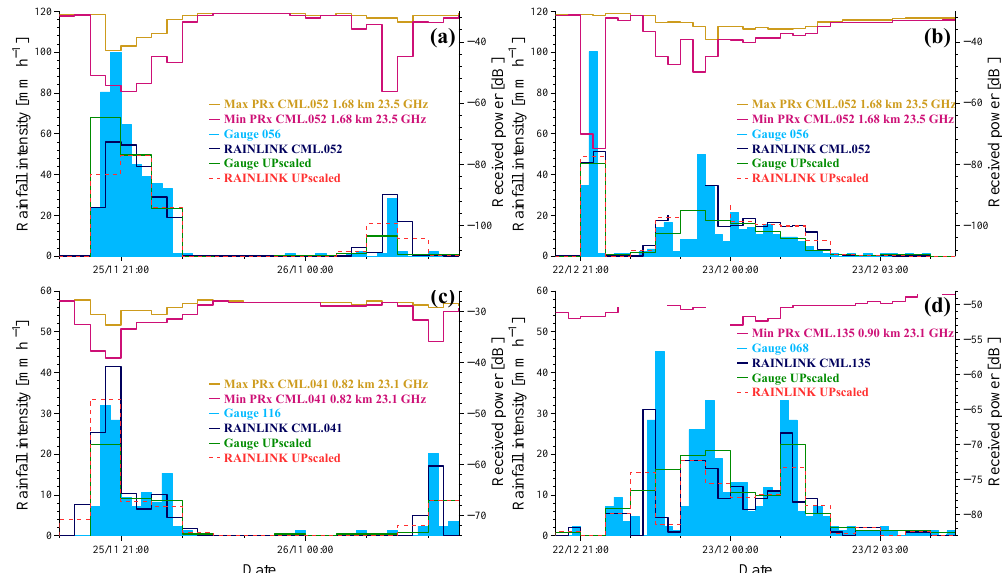
Figure 5. Time series of two rainfall events (November and December 2014, panels (a,c) , and (b,d) , respectively) for the three best per- forming CMLs, i.e. CML 052 (a, b) , CML 041 (c) , and CML 135 (d) . Their evaluation is done against gauges 56, 116, and 68. CML 135 is an ER link, whereas CML 052 and 041 are HU links (see Fig. 1). Cyan is for 10min gauge measurements, blue is for 15min RAINLINK estimates, green is for 30min upscaled gauge measurements, red is for 30min upscaled RAINLINK estimates, and pink and gold are for 15min minimum and maximum received powers, respectively. ER CML only sampled minimum received power. The RAINLINK series are computed for the local DSD parameters (Fig. 3, SP R − k relation).